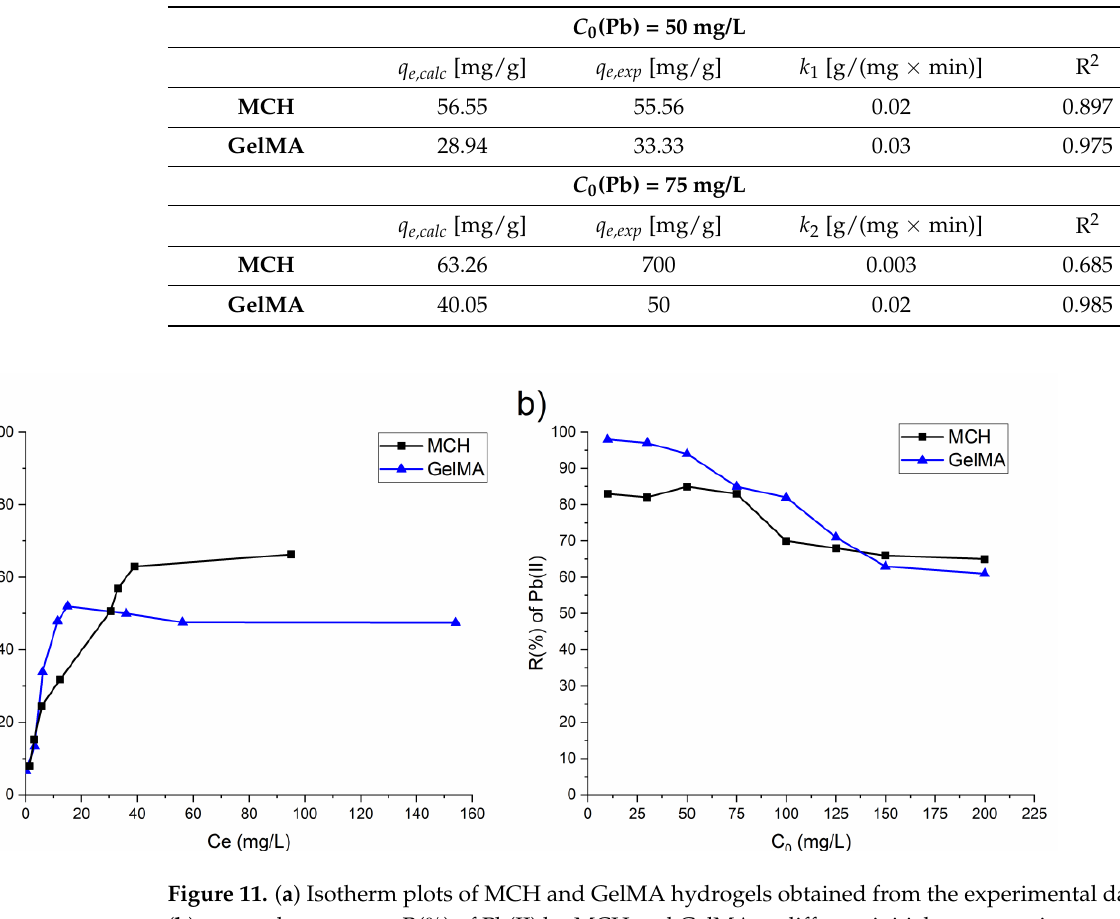
15 of 19 Table 4. Pseudo-second order fitting parameters for Pb(II) adsorption. C 0 (Pb) = 50 mg/L